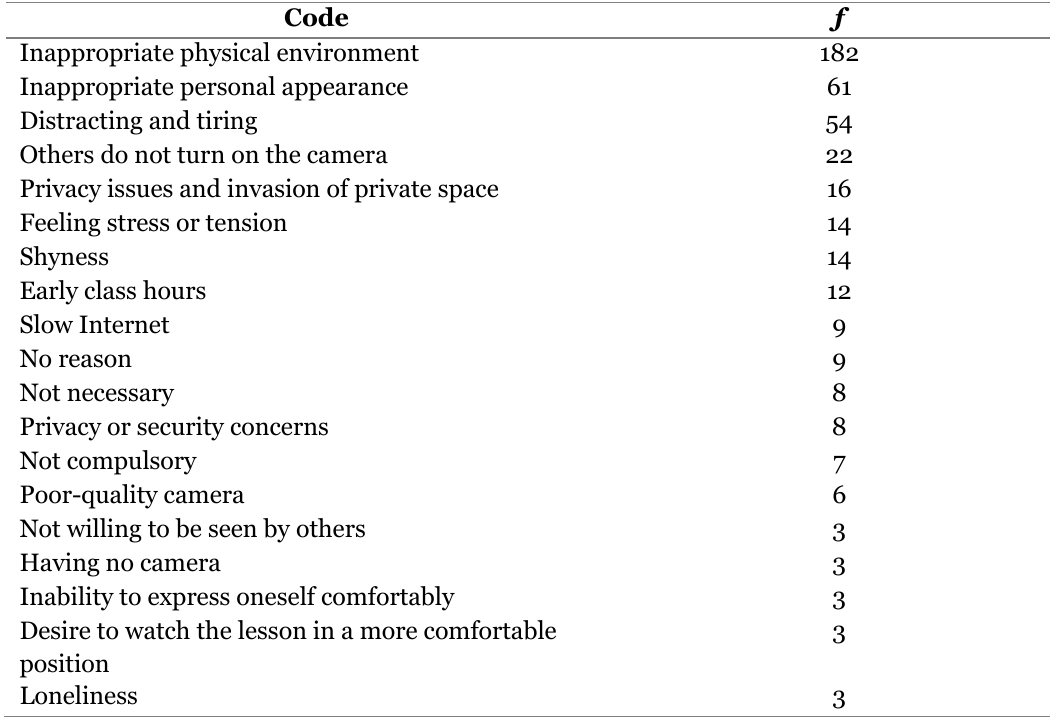
Table 5 Reasons for Not Turning on Their Cameras in